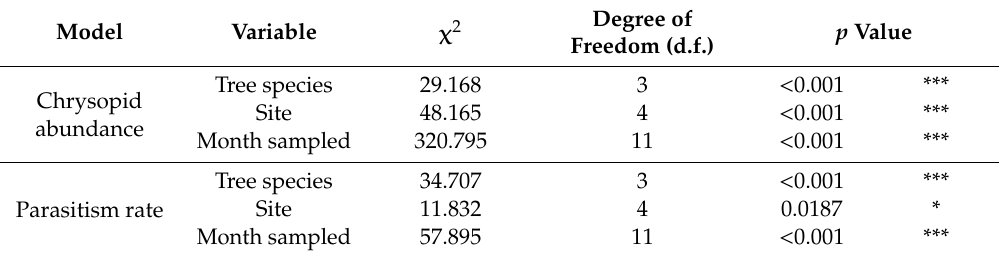
Table 3. ANOVA (type II Wald Chi-square test) results of generalized linear mixed models